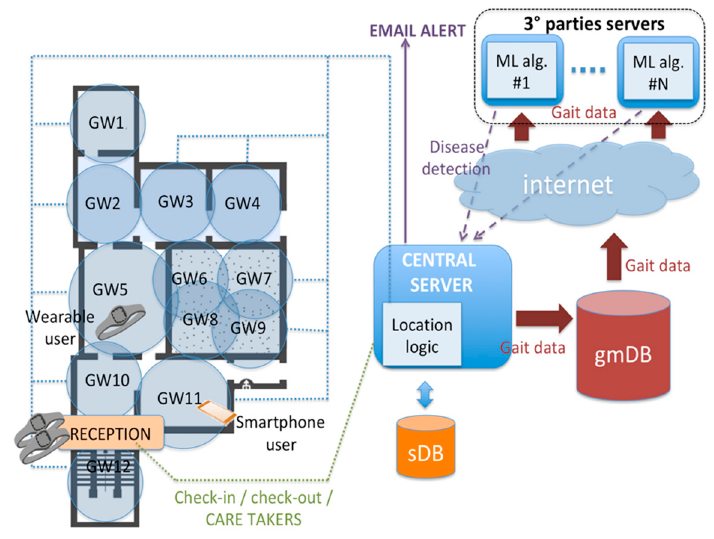
Figure 2. Architecture of fall detection and gait monitoring system.